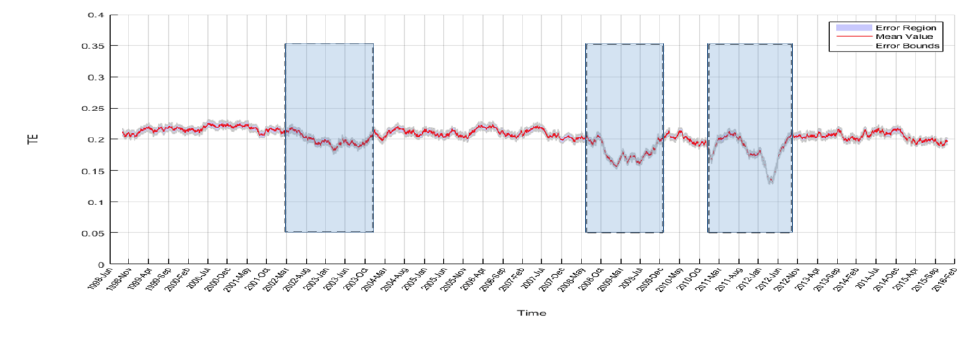
Figure 10.The average transfer entropy for the Dow Jones